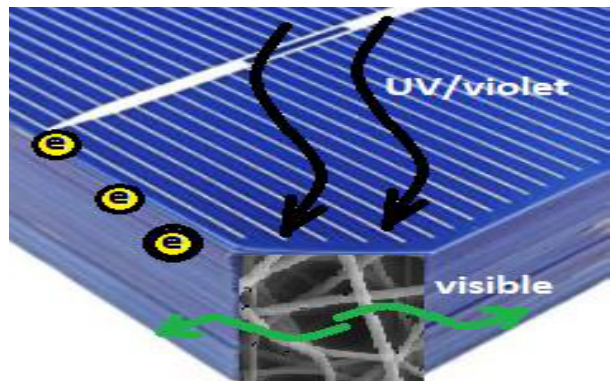
Figure 1. Simple schematic diagram to show the idea of the work; the nanocomposite rear coater is converting the transmitted UV/violet to visible light. In addition, the nanocomposite helps to offer better electric paths for the generated photoelectrons to the electrodes.